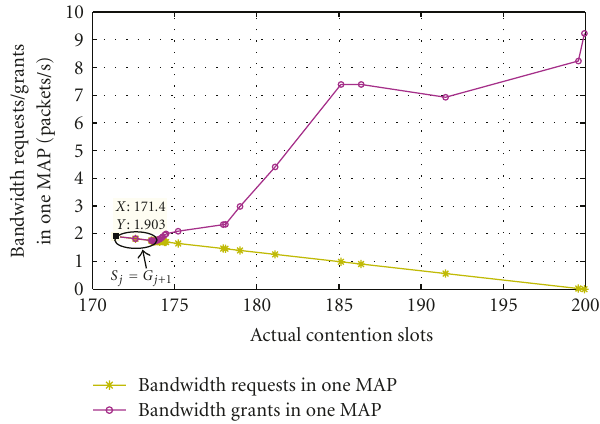
Figure 8: The bandwidth request versus the bandwidth grants of one multicast group during one MAP, V =